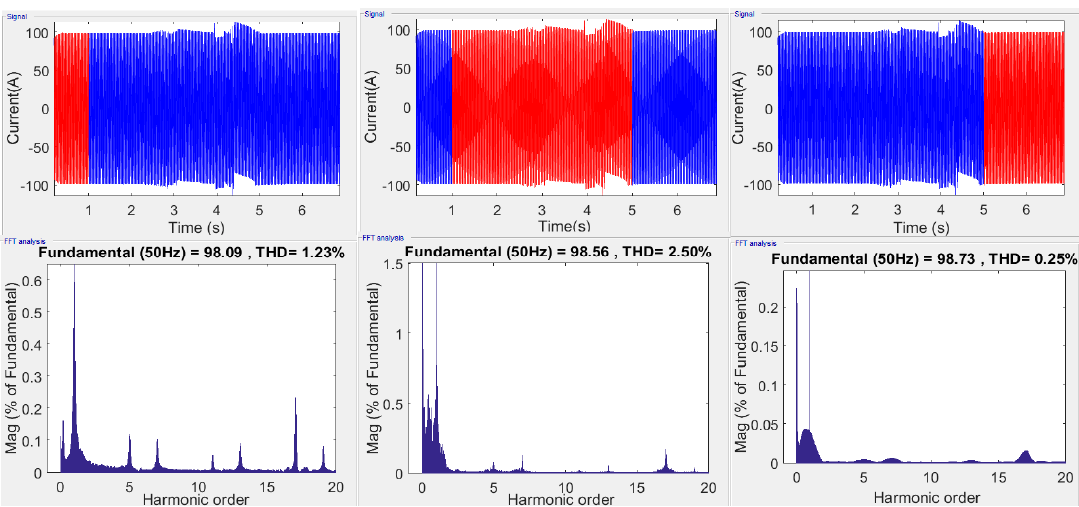
Figure 21. Harmonic diagram of load current under integrated control strategy.